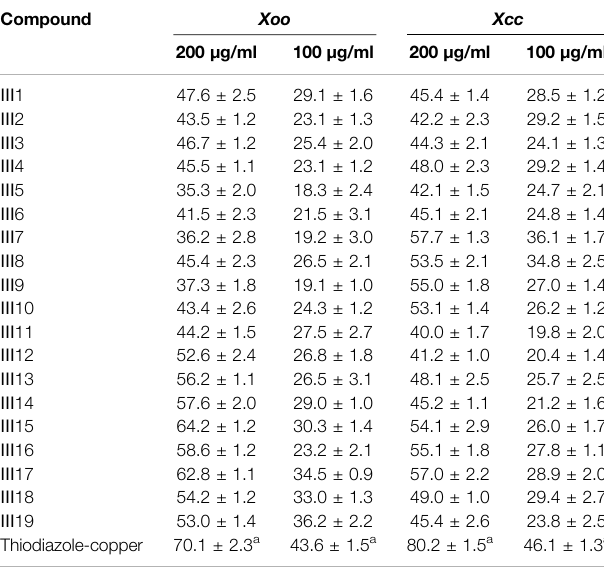
TABLE 4 | Antibacterial activity of compounds ( Ⅲ 1 – Ⅲ 19) in vitro .